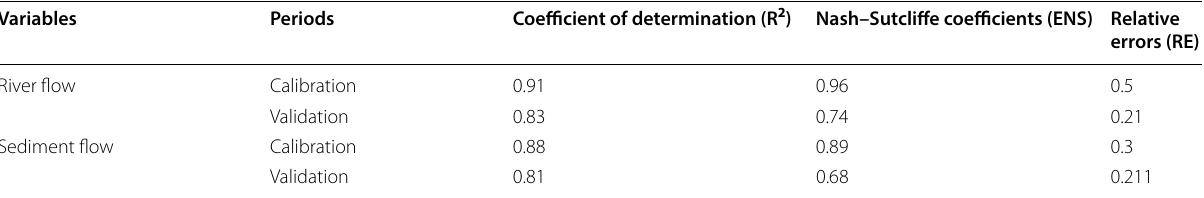
Table 3 Evaluation of the accuracy of the SWAT model